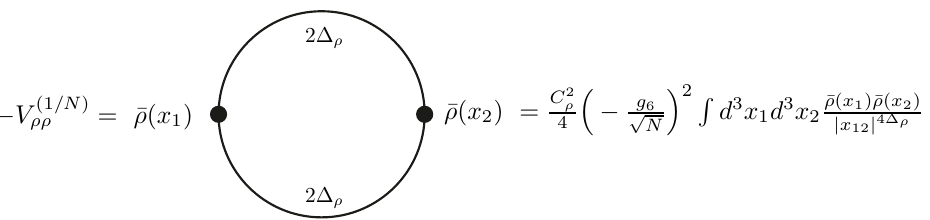
Figure 4 . The (1 /N ) correction to the quadratic effective action of ρ , where ¯ ρ is the background O field. The solid dots represent the cubic vertex with one of the legs substituted by the background g 6 ¯ ρ , and 1 / 4 is the symmetry factor. ¯ ρ , i.e. √ N −